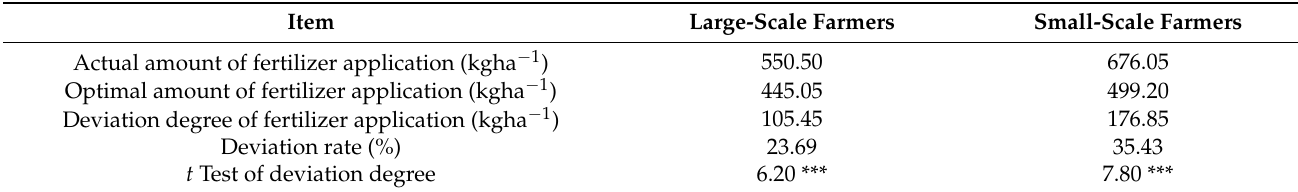
Table 5. Deviation of fertilizer application between large-scale and small-scale farmers.